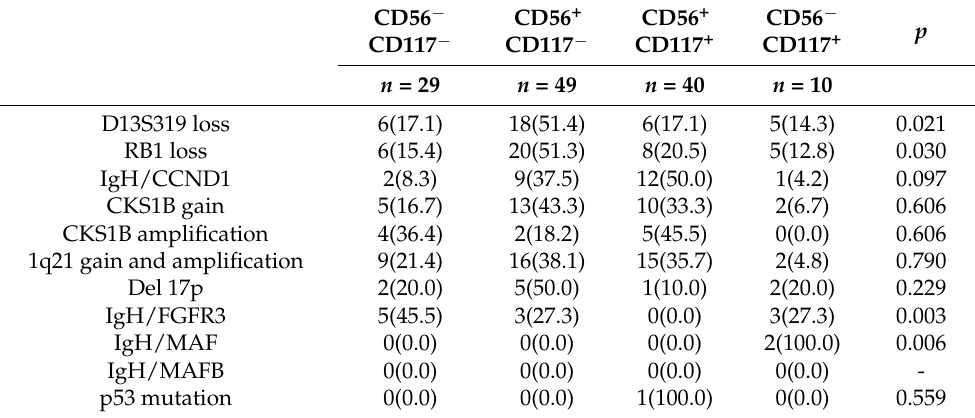
Table 3. Cytogenetic abnormality categorized by CD56 and CD117